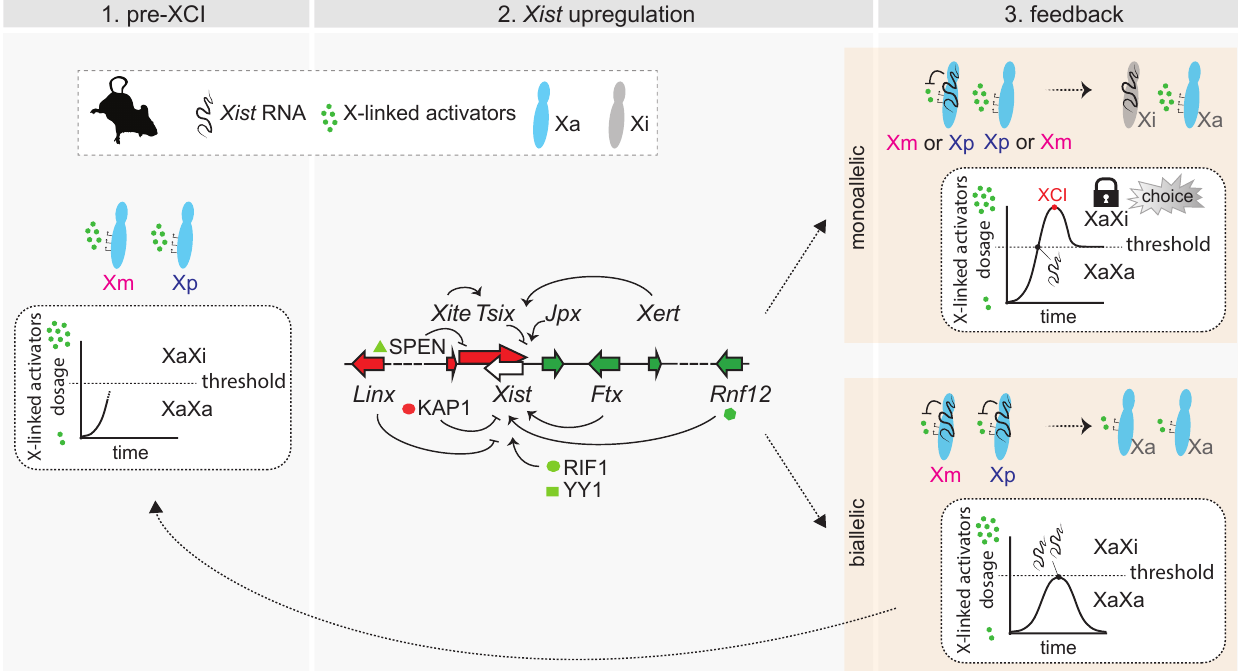
Figure 3. Dynamic model of choice during random XCI. Left : Pre-XCI status. Both X chromosomes are active and transcribe X-linked genes. The dose of X-linked activators increases towards the threshold necessary for productive Xist upregulation. Middle : Biallelic X-chromosome transcription allows the cell to reach the threshold for Xist activation. X-linked and autosomal cis and trans positive and negative regulators influence the initiation of Xist upregulation, which can occur on a single X chromosome or on both. Only factors and loci discussed in the text have been included in the figure. Right (top) : In cells that have upregulated Xist monoallelically, X-wide cis -silencing triggered by Xist RNA causes a drop in the level of activators, preventing the second chromosome from upregulating Xist . Choice is locked-in. Monoallelic Xist expression (and cis -silencing) has to be sustained, either through enough dosage of activators and/or feedback mechanisms. Right (bottom) : In cells that have upregulated Xist biallelically, excess Xist expression triggers rapid downregulation of X-linked activators on both X chromosomes, and this drop in levels below the threshold causes Xist expression to switch off. Both X chromosomes remain active and the process must start